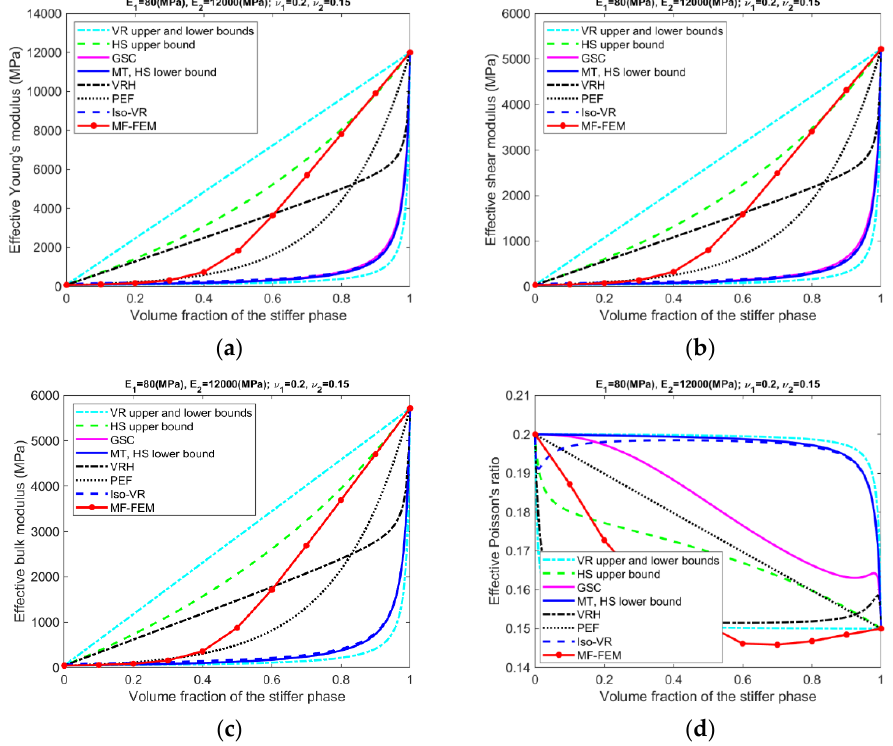
Figure A3. Composite #3—large contrast in phase Young’s modulus and small contrast in phase Poisson’s ratio. ( a ) Young’s modulus; ( b ) shear modulus; ( c ) bulk modulus; ( d ) Poisson’s ratio.